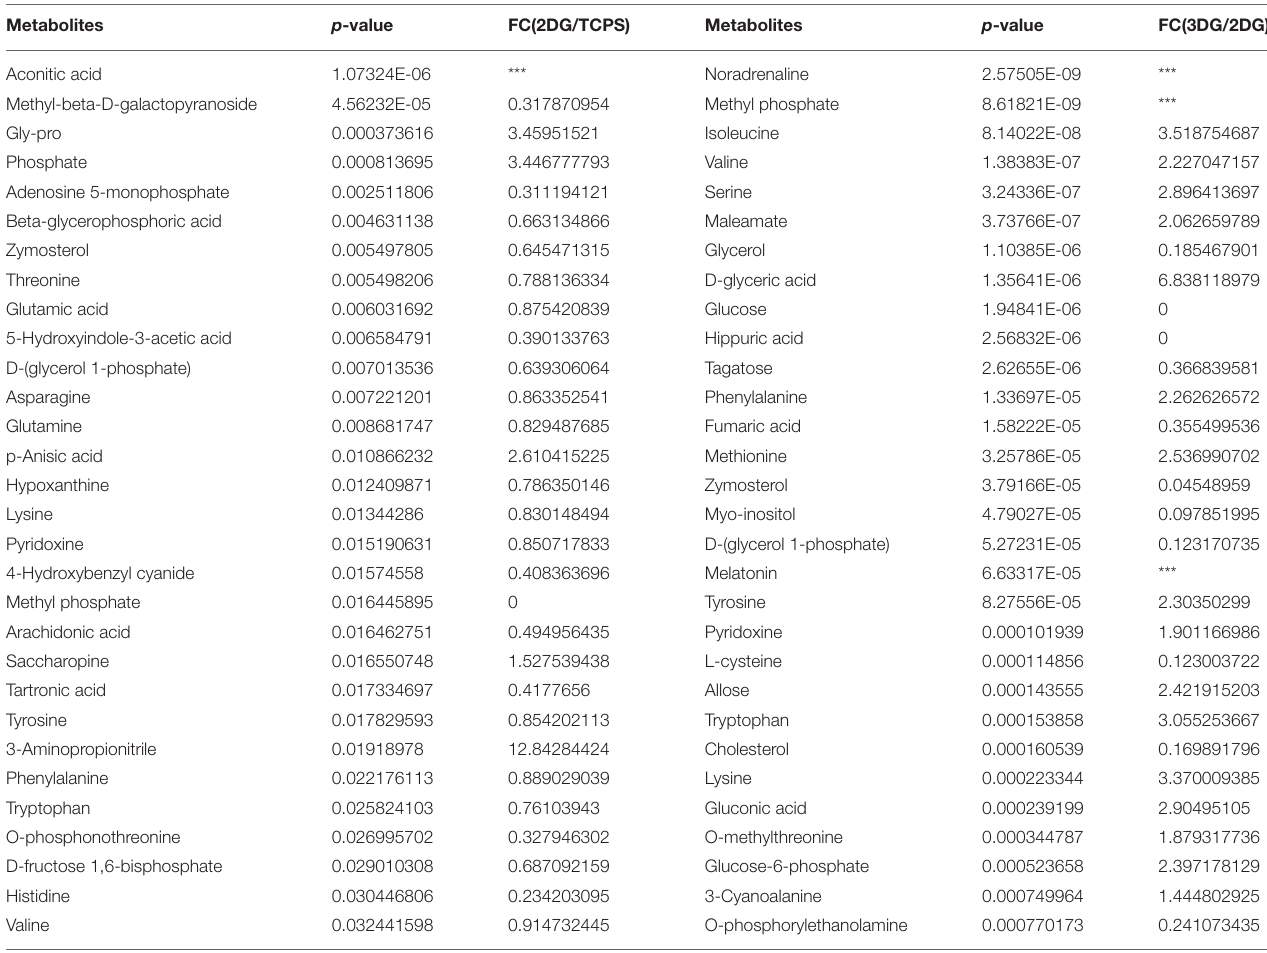
TABLE 1 | The top 30 metabolites contributing significantly to discriminating cells grown on 2DG from those grown on TCPS and discriminating cells grown on 3DG from those grown on